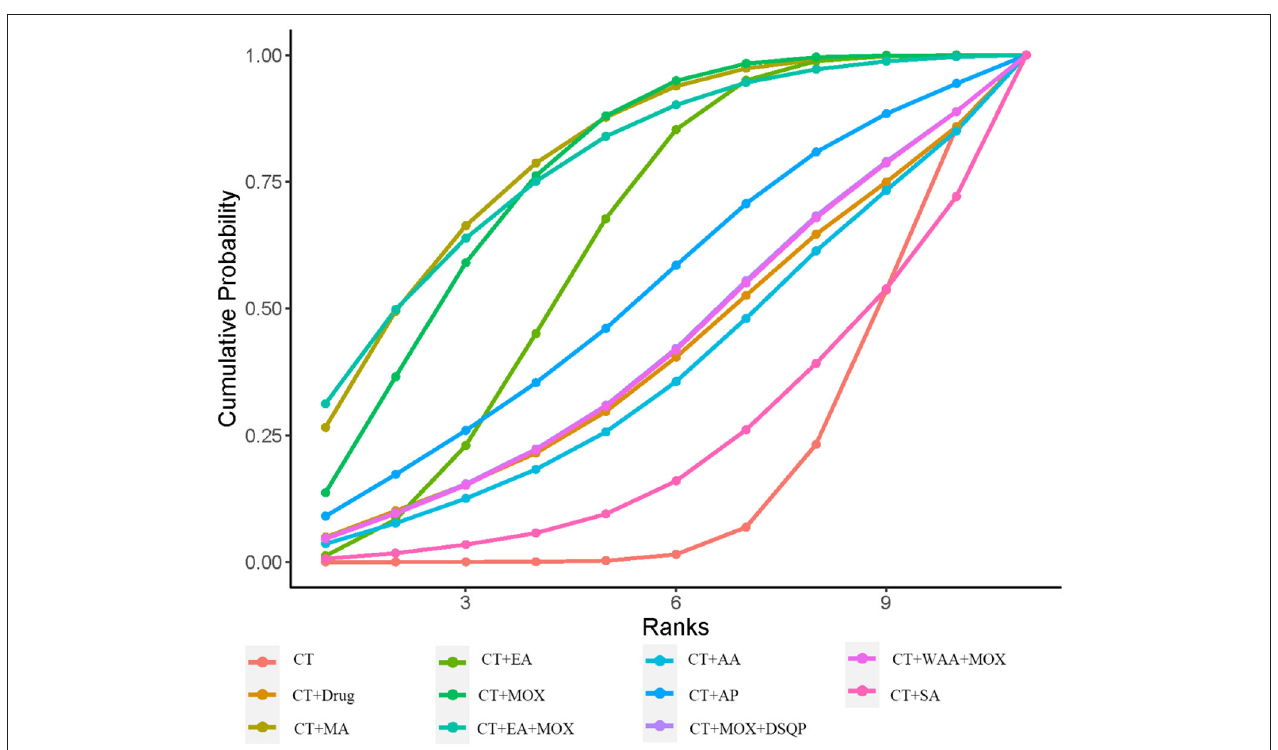
FIGURE 6 | Cumulative probability ranking curve of different interventions for RUV. The vertical axis represents cumulative probabilities, while the horizontal axis represents ranks.